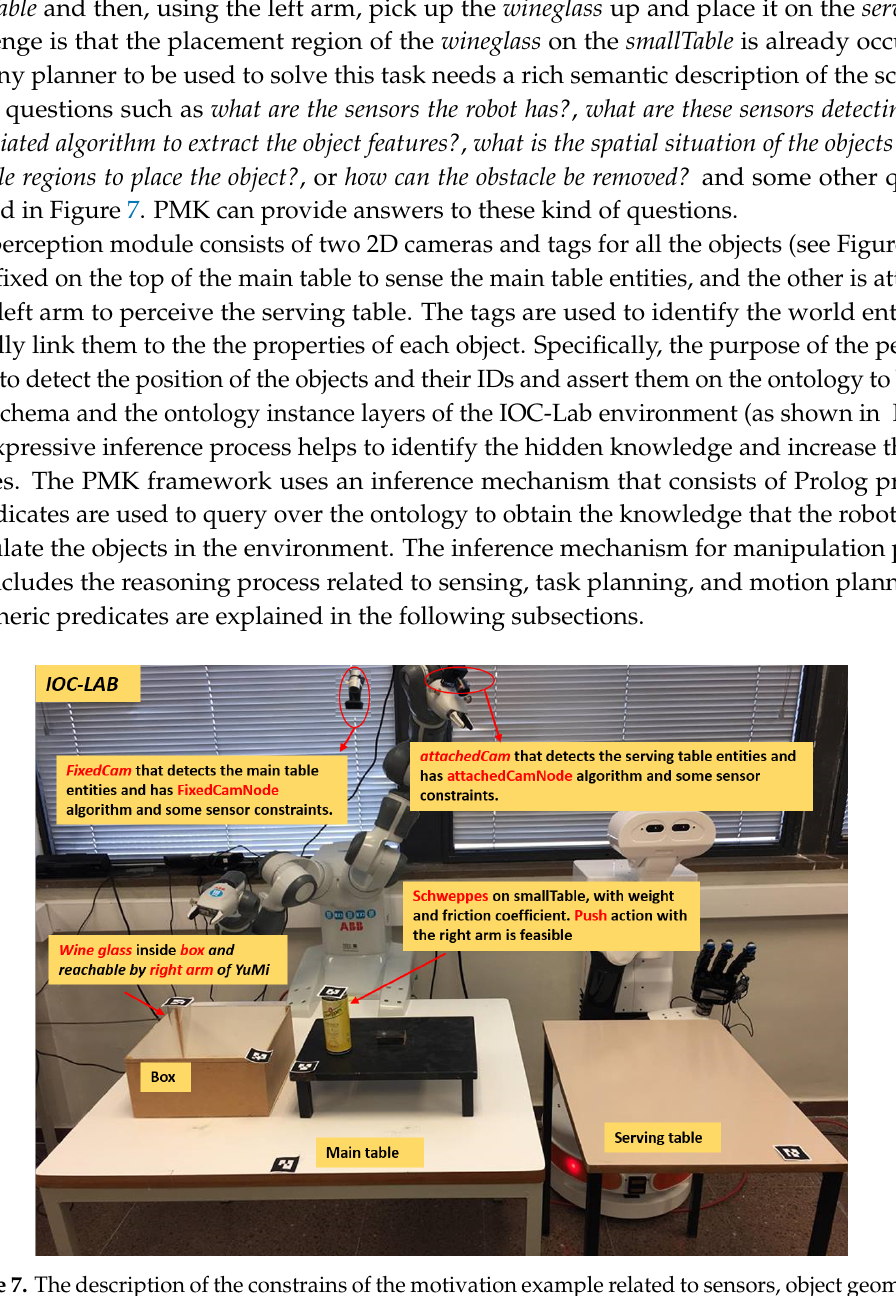
Figure 7. The description of the constrains of the motivation example related to sensors, object geometry, interaction learning, and action